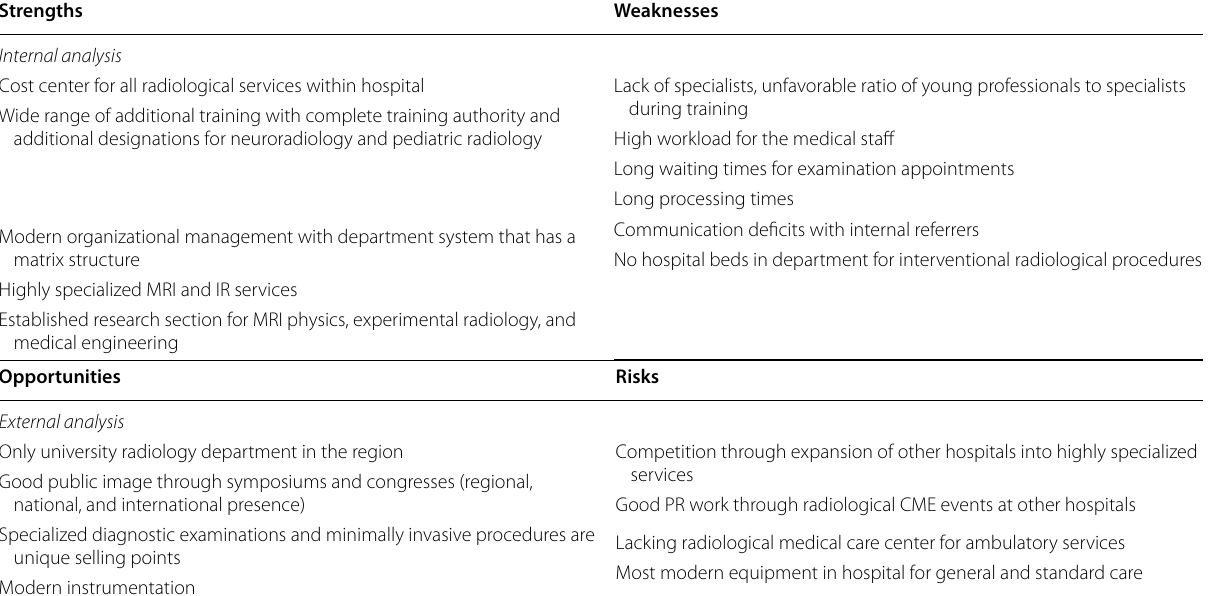
Table 1 Strengths/weaknesses and opportunities/risks (SWOT-) analysis